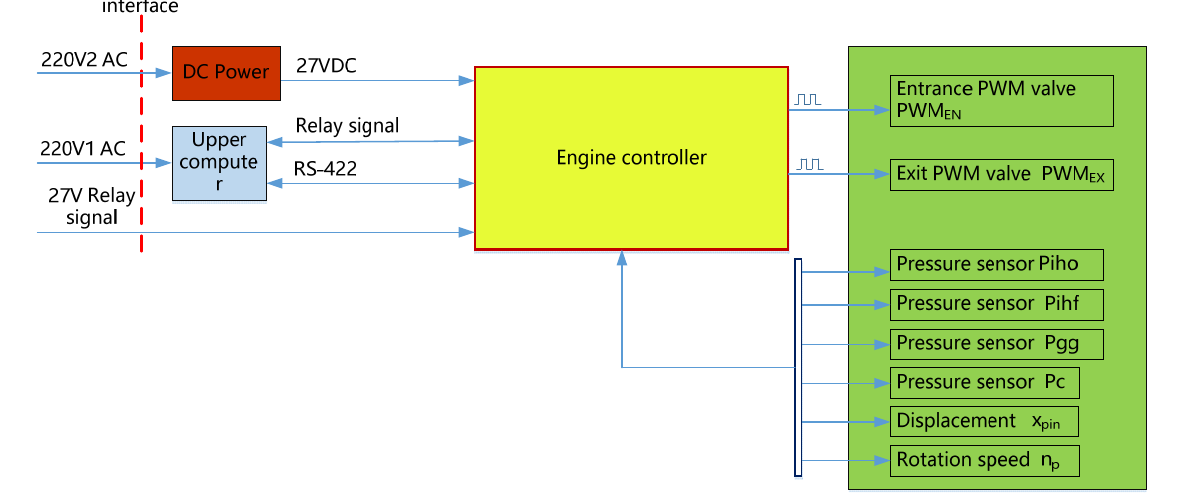
Figure 7. The working principle of experiment facilities.